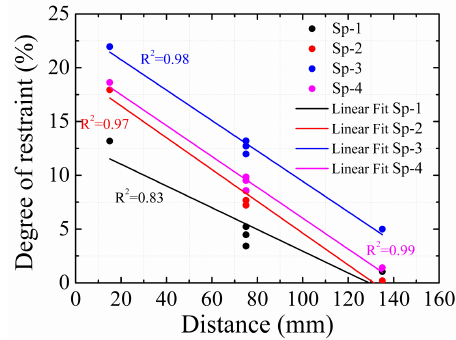
Figure 8. Distribution of average degree of restraint throughout the age of the